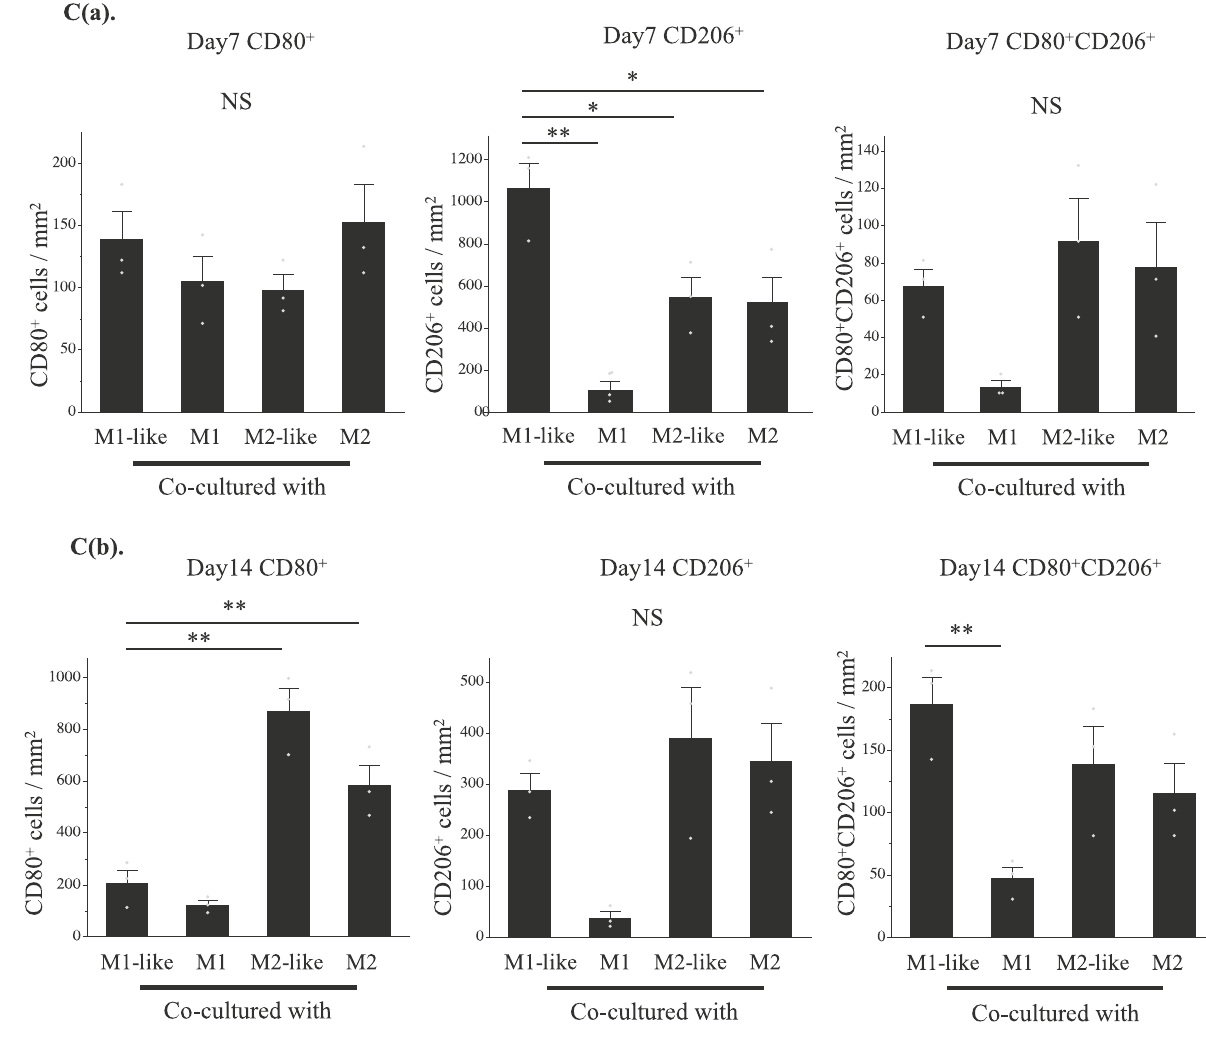
Figure 3. C(a) Quantitative evaluation based on the CD80 + , CD206 + , and CD80 + CD206 + cell count in double immunofluorescence staining (on day 7 of co-culture). Left: CD80 + cells, Middle: CD206 + cells, Right: CD80 + CD206 + cells. *P < 0.05, **P < 0.01. NS: Not significant. The data are presented as the mean ± SEM (n =